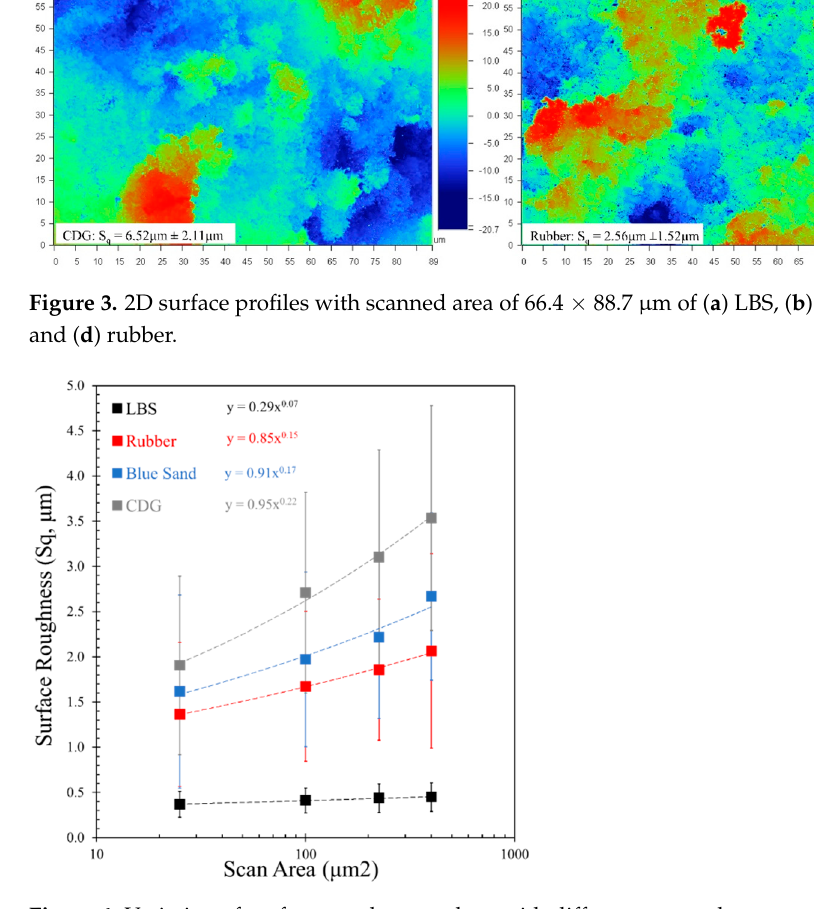
Figure 4. Variation of surface roughness values with different scanned areas.